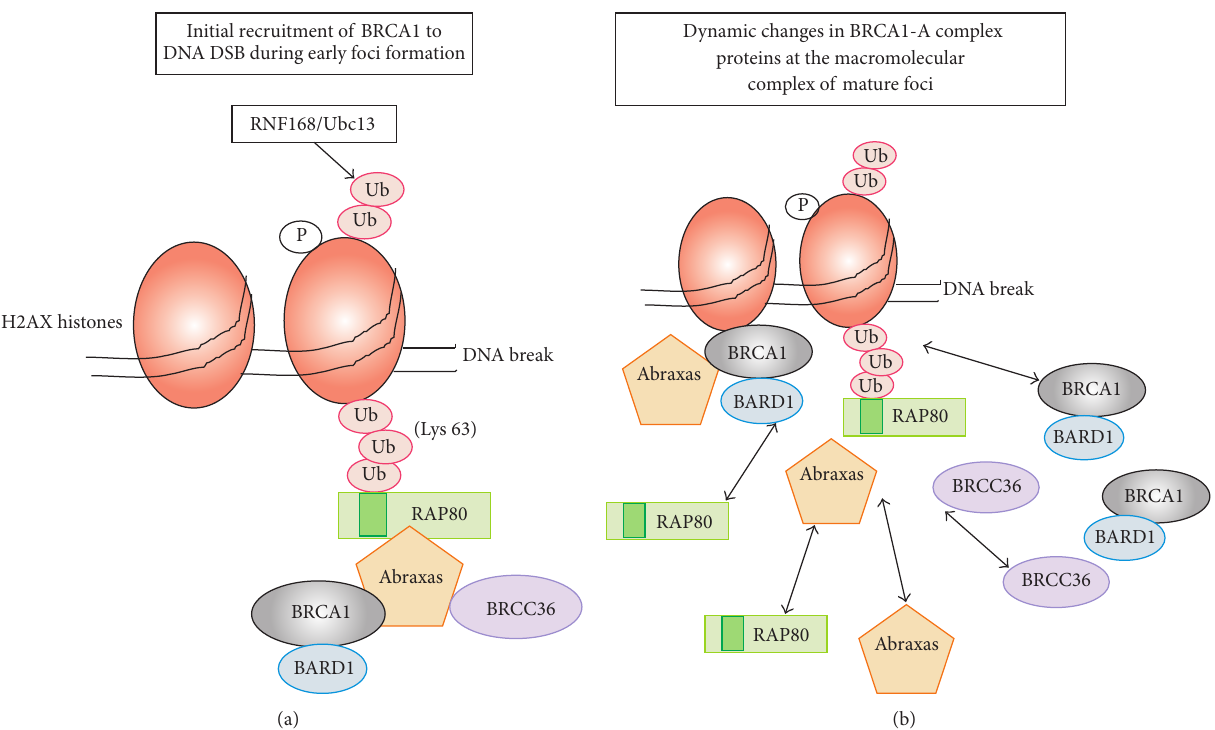
of total ) transiently %